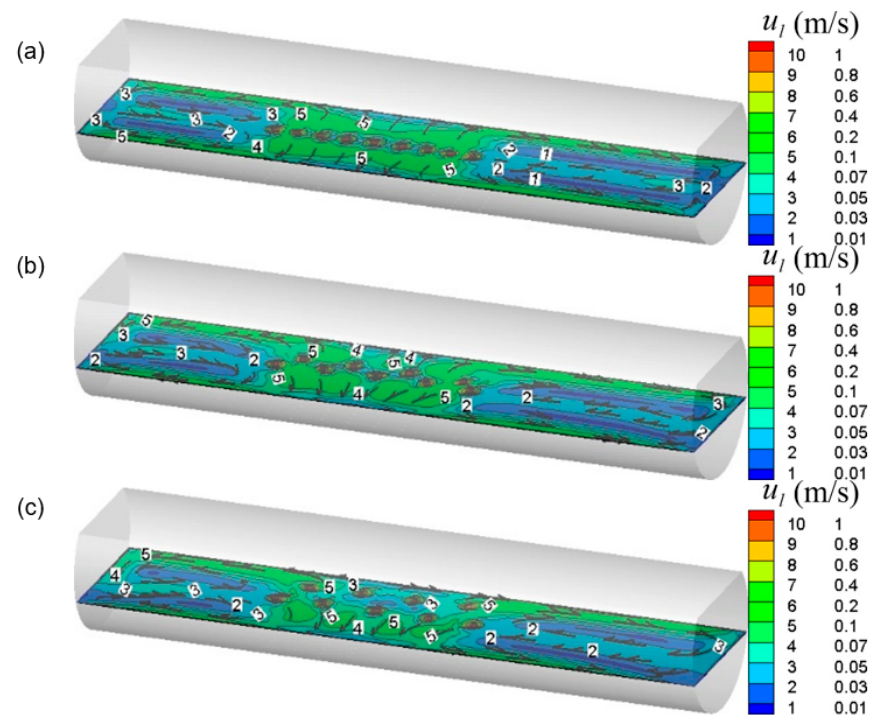
Figure 8. Predicted typical local liquid flow filed in the bath with different nozzle arrangements, where the β A is 0 ° , and the β B is ( a ) 0 ° , ( b ) 14 ° , and ( c ) 28 ° , respectively.